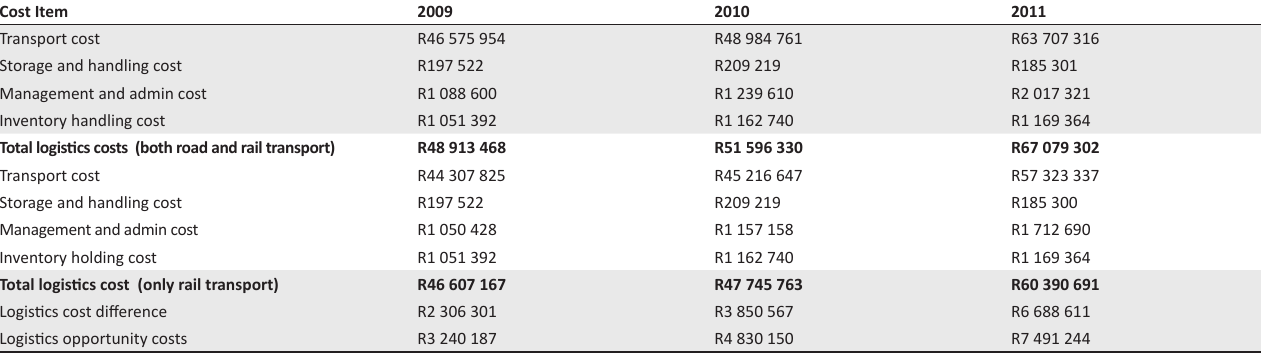
TABLE 5: Logistics opportunity costs of using road transport (2009–2011).